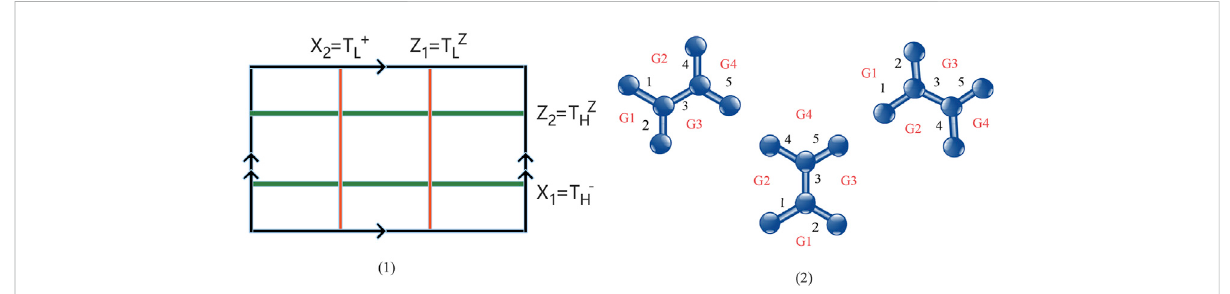
FIGURE 2 (1)Uncomplicated example of two sets of logical operators on a torus, with arrows denoting the identi fi ed boundaries. (2)The three possible edgeorientationsontheXoperatorcanbeapplied.Thequbitmarked3isin fl uencedinanycase,inadditiontothis,itmayleave fl uxexcitationsonthe four surrounding plaquettes labeled by G 1, G 2, G 3, G